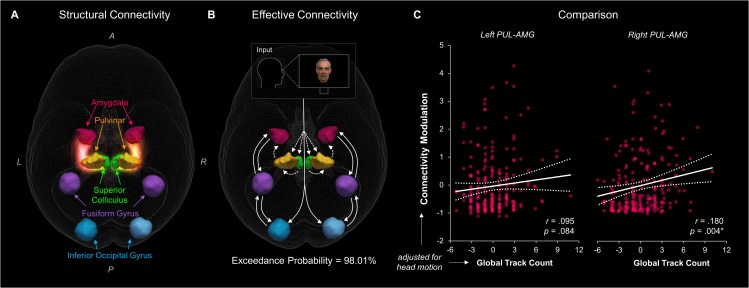
The relationship between structural and effective connectivity for the subcortical route.(A and B) show 3D renders of the ROIs used in the dynamic causal modelling stage. A = anterior, p = posterior, R = right, L = left. (A) 3D-rendered tracks generated by global tractography overlaid for all 622 participants (pink/orange for PUL-AMG, green/yellow for SC-PUL). (B) Direction of information flow according to the winning dynamic causal model (exceedance probability = 98.01%) illustrated using an axial view of the network. Dotted lines indicate subcortical input/connections. (C) Positive correlation between global track count for the left and right PUL-AMG connections and the modulatory strength of the same connection in the winning effective connectivity model (with 95% CI shown).